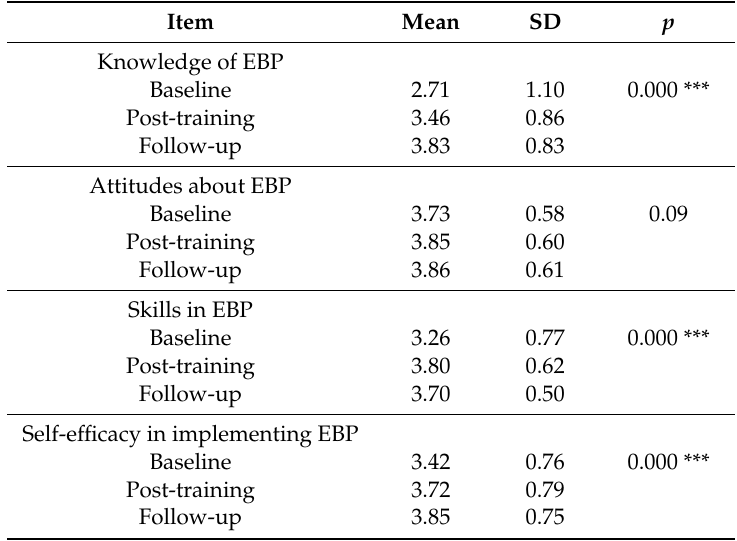
Table 4. Descriptive statistics for the learning e ff ectiveness of the EBP training program over time ( N = 193). Item Mean